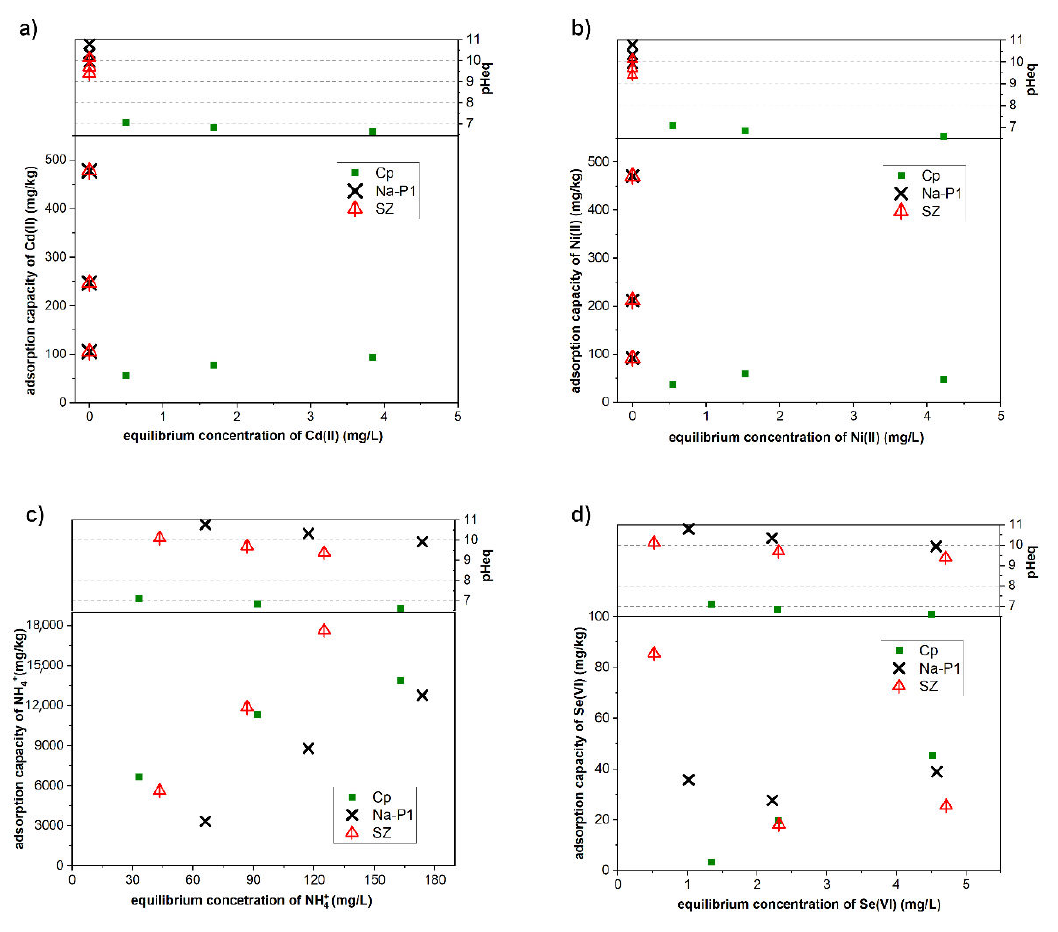
Figure 7. Sorption isotherms for ( a ) Cd(II); ( b ) Ni(II); ( c ) NH 4 + ; and ( d ) Se(VI) on Cp, Na-P1, and SZ. The value above sorption isotherms indicates pH eq